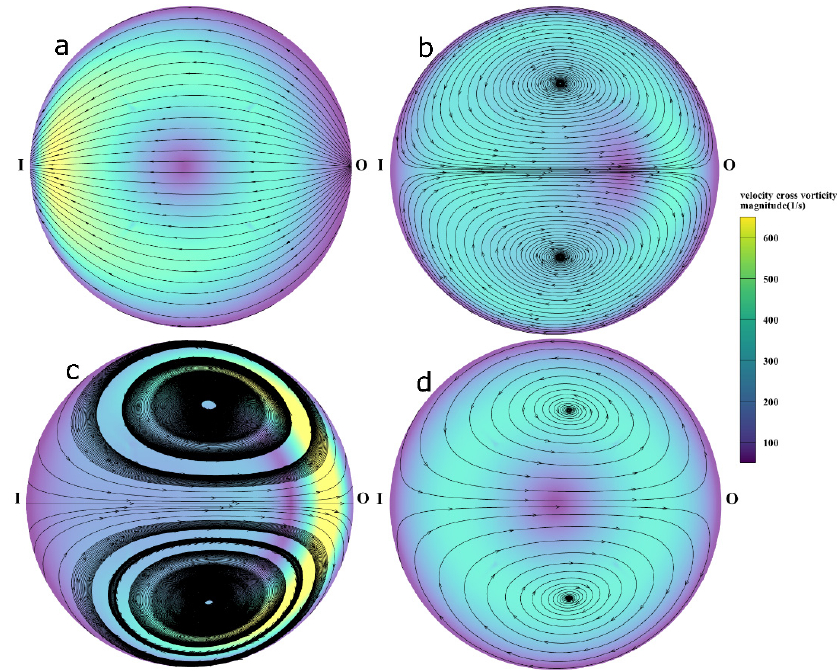
Figure 13. In the 45 ◦ channel at the conveying rate of 4.75 cm 3 /s, the profiles of the velocity cross vorticity magnitude and the projected streamlines. The slices ( a – d ) are from the second slice to the fifth slice shown in Figure